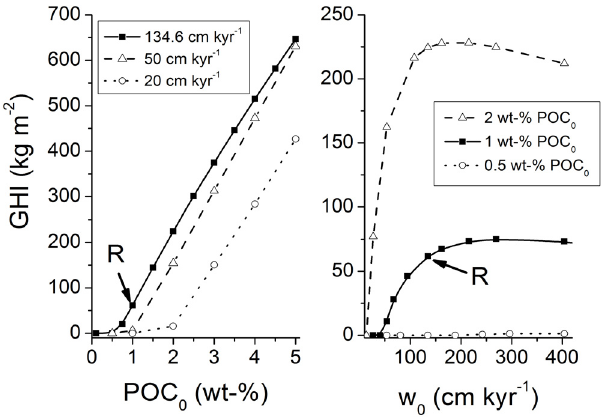
Figure 17. Effect of GHSZ thickness on methane hydrate accumulation in marine sediments. L denotes the thickness of the gas hydrate stability zone. It was varied by changing the GHSZ heat flow applied in the reference model run over a range of q corresponding to temperature gradients of 20–100 °C km − 1 . In the left panel, the burial velocity at the interface was maintained at the reference value ( w right panel shows model results with diminished w